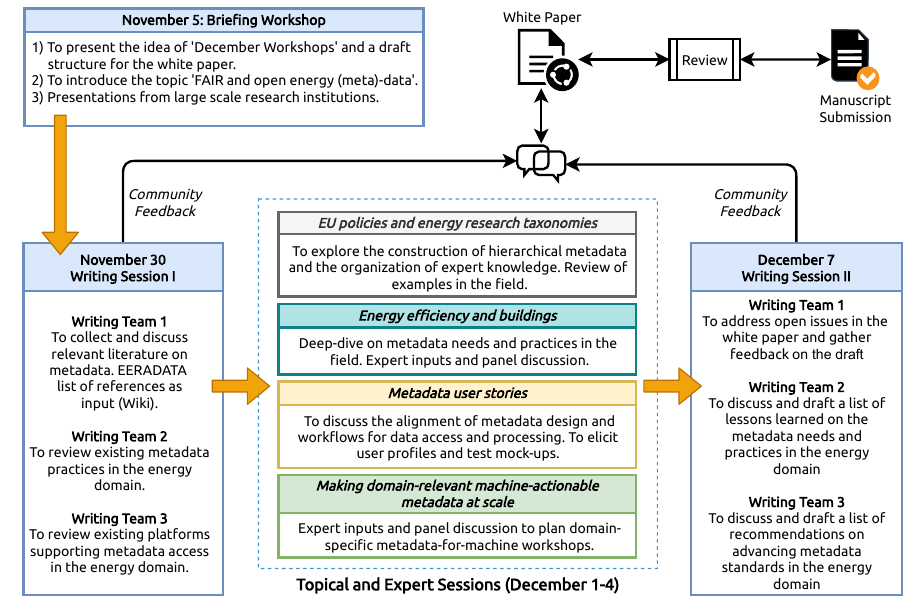
Figure 1. Method for drafting the community report. Details on the design of workshops and links to materials are provided in the Supplementary